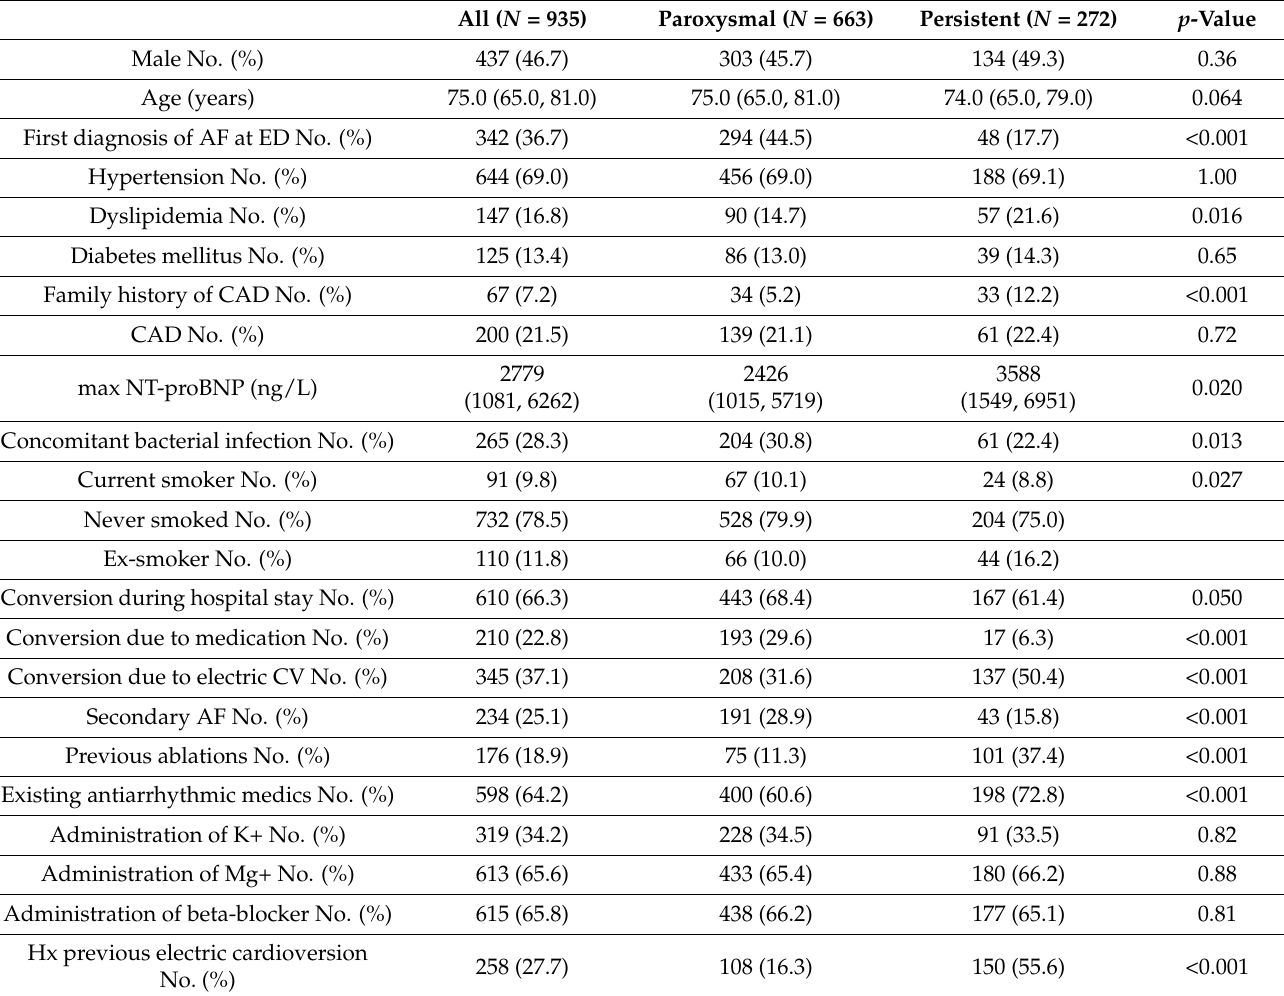
Table 1. Patient